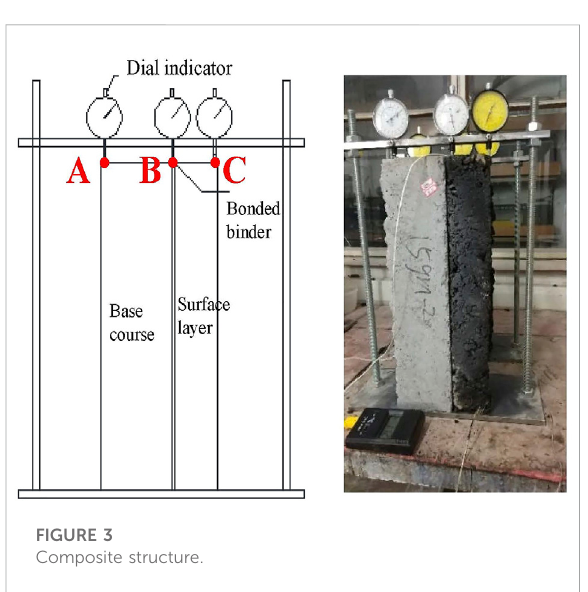
FIGURE 3 Composite